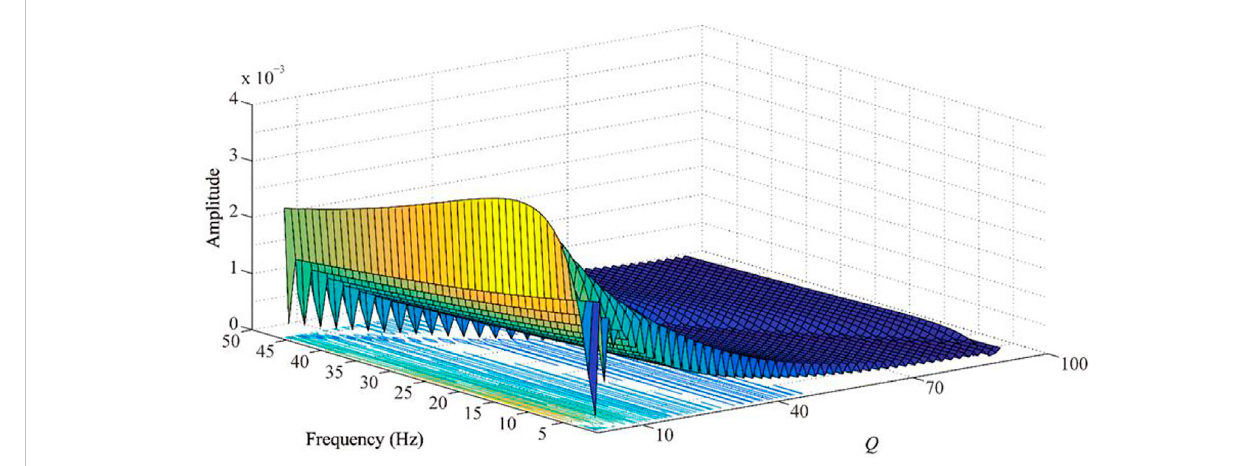
FIGURE 1 RRMS with different parameters.